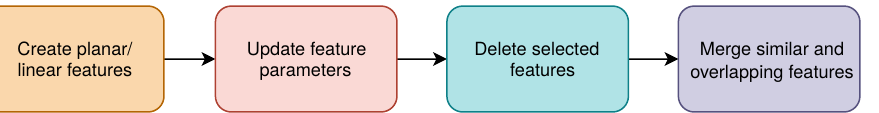
Figure 4. Processing pipeline implemented in the system, consisting of creating, updating, deleting and merging features.